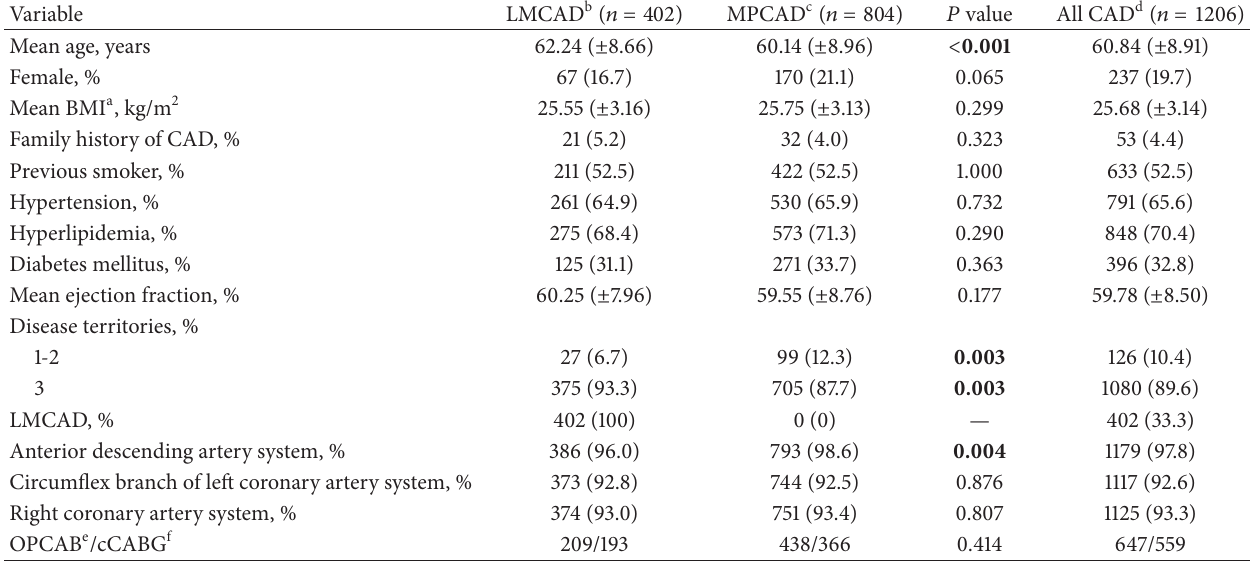
Table 1: Patient demographics and risk factors for CAD (LMCAD and MPCAD) (all subjects).